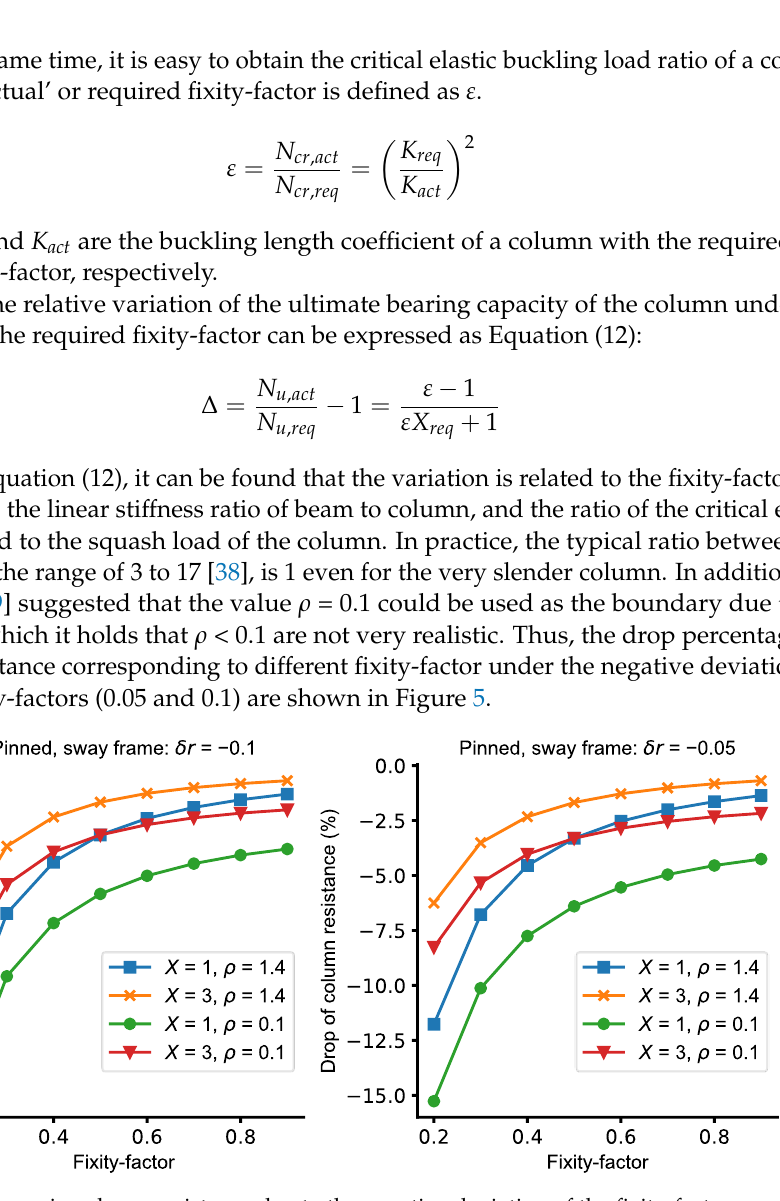
Figure 5. Decrease in column resistance due to the negative deviation of the fixity-factor.